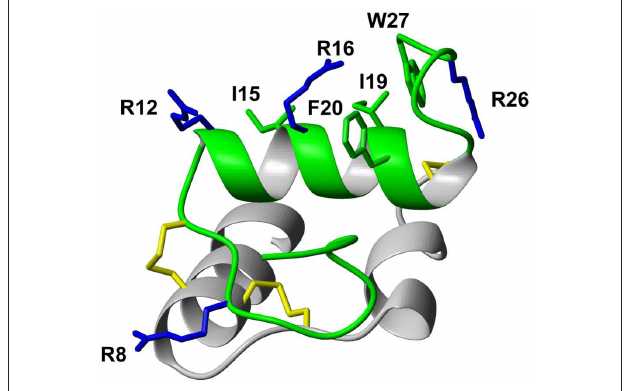
FIGURE 1 | Relaxin-3 solution NMR structure. The A-chain (gray) and B-chain (green) are cross-braced by one intramolecular disulfide bond in the A-chain and two intermolecular disulfide bonds (yellow). Important relaxin-3 B-chain residues involved in binding and activation of RXFP3 are shown in sticks and colored blue and green for basic and hydrophobic residues,